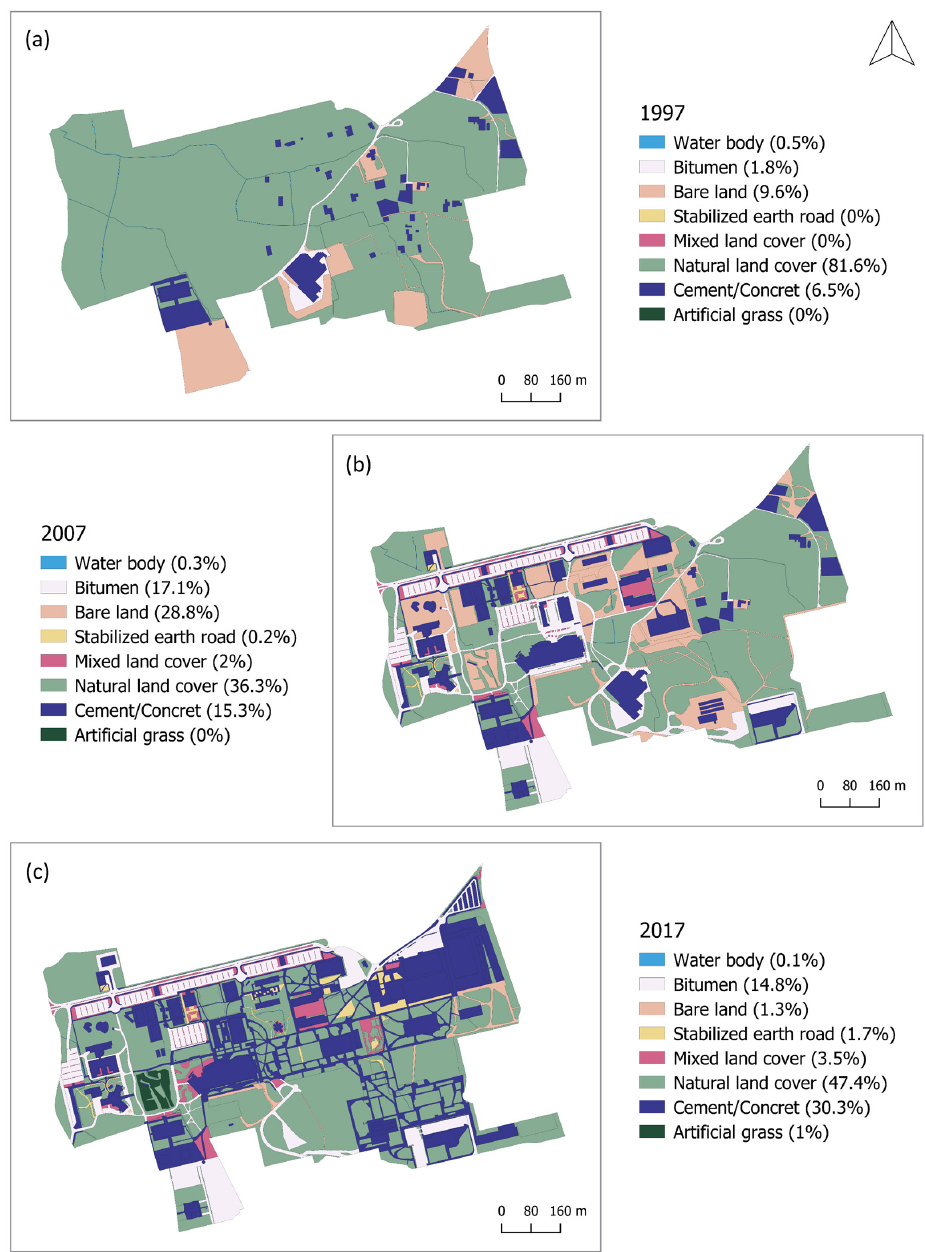
Figure 2. Maps of the land cover of the UMH campus in ( a ) 1997; ( b ) 2007; ( c ) 2017.